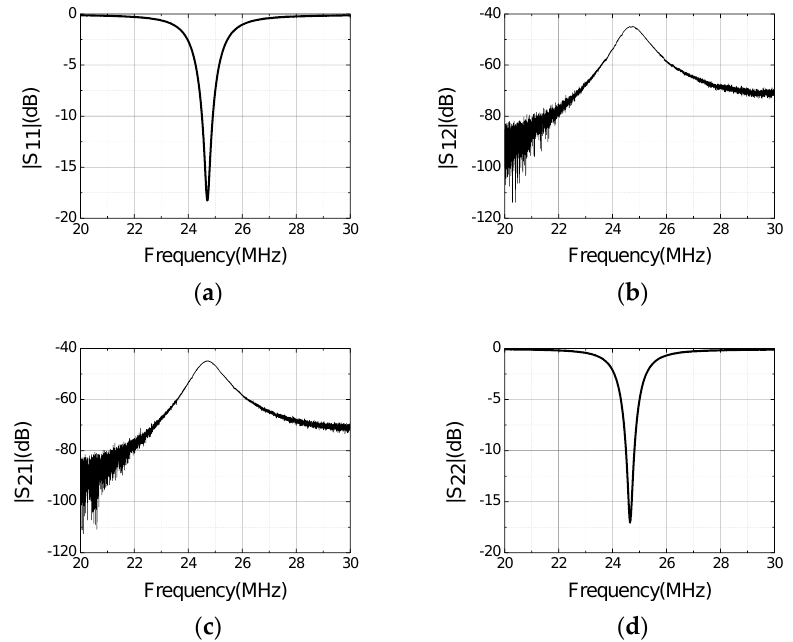
Figure 12. The measurement performances of the prototype probe: ( a ) S 11 ; ( b ) S 12 ; ( c ) S 21 ; ( d ) S 22